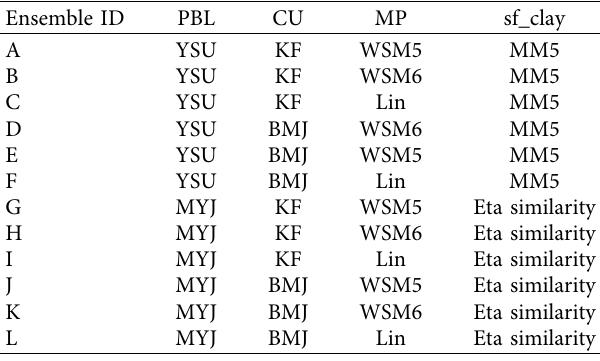
Table 1: Ensemble design.